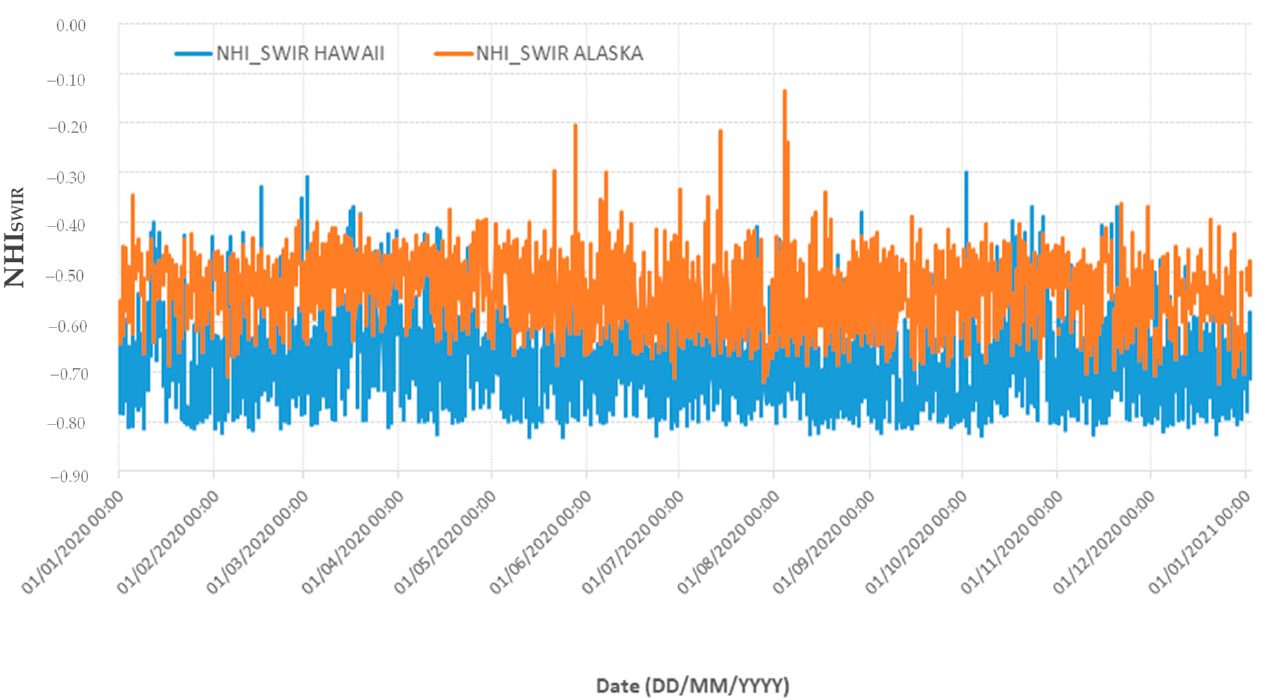
Figure 9. Time series analysis of the NHI SWIR index retrieved from one year of daytime GOES-R (GOES-17) observations (17:10 UTC–03:50 UTC) over the selected background pixels of Hawaii (21.54 N, 157.99 W) (blue curve) and Alaska (60.07 N, 149.95 W) (orange curve).